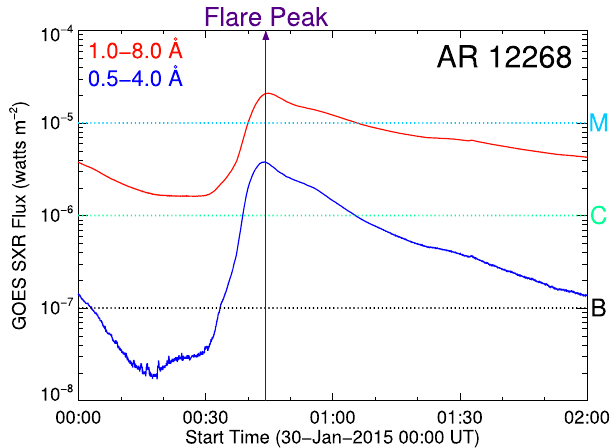
Fig. 1 GOES soft X-ray fl uxes of the M2.0 class solar fl are on 30 January 2015 at 1.0 – 8.0 Å (red curve) and 0.5 – 4.0 Å (blue curve). The purple vertical line shows the peak time of the fl are at 00:44 UT. The three letters of M, C, and B represent the fl are classes, according to the X-ray peak fl ux at 1.0 – 8.0 Å